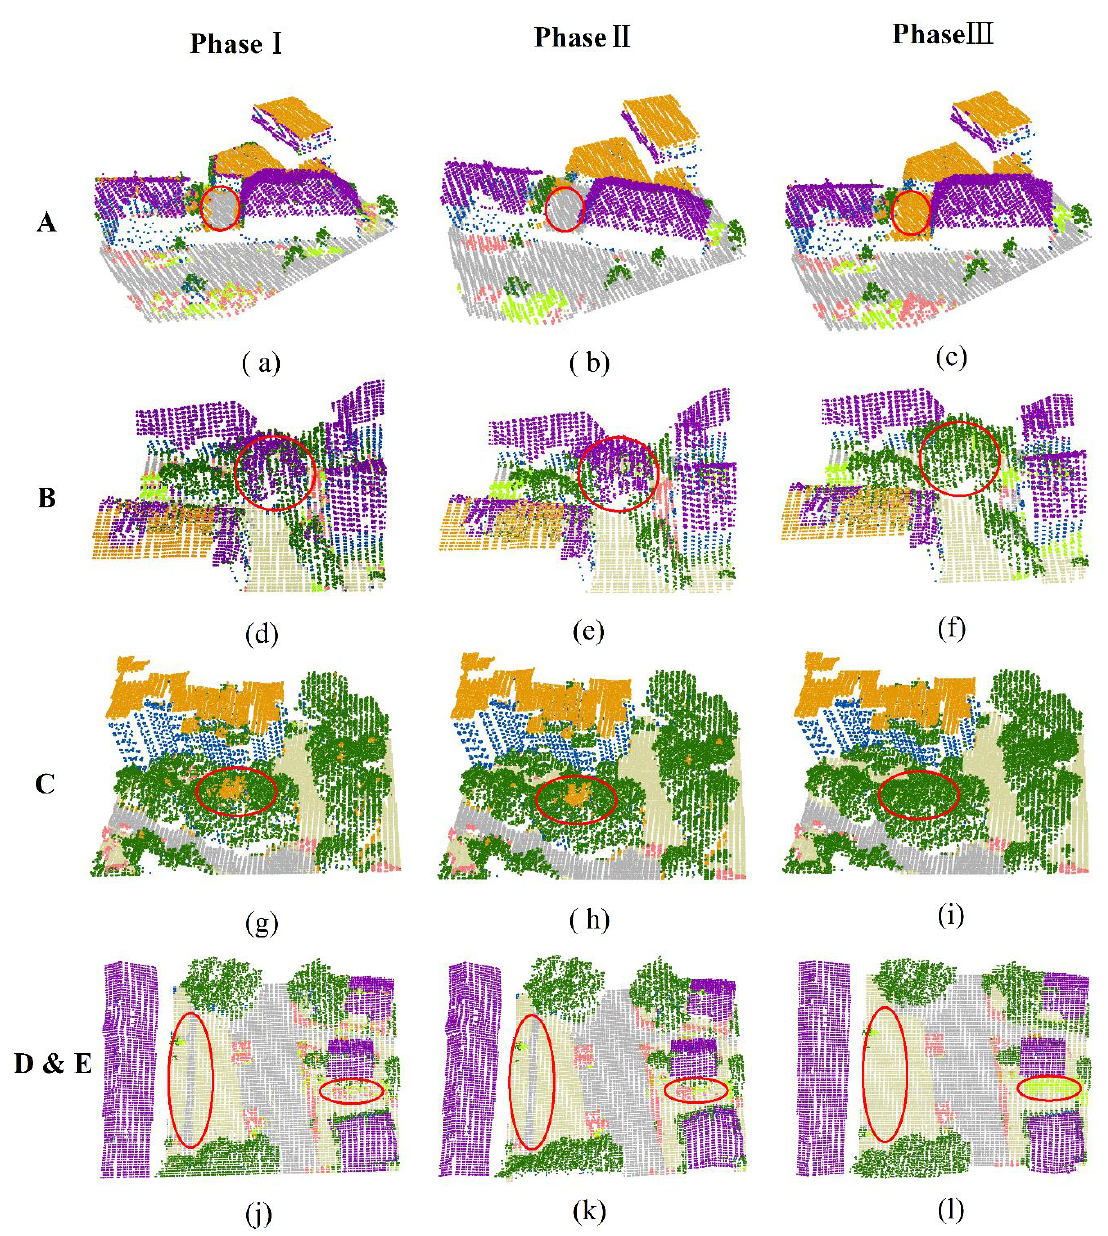
Figure 6. Comparisons of some classification results for the three phases. ( A – E ) correspond to the locations marked in Figure locations marked in Figure 2.